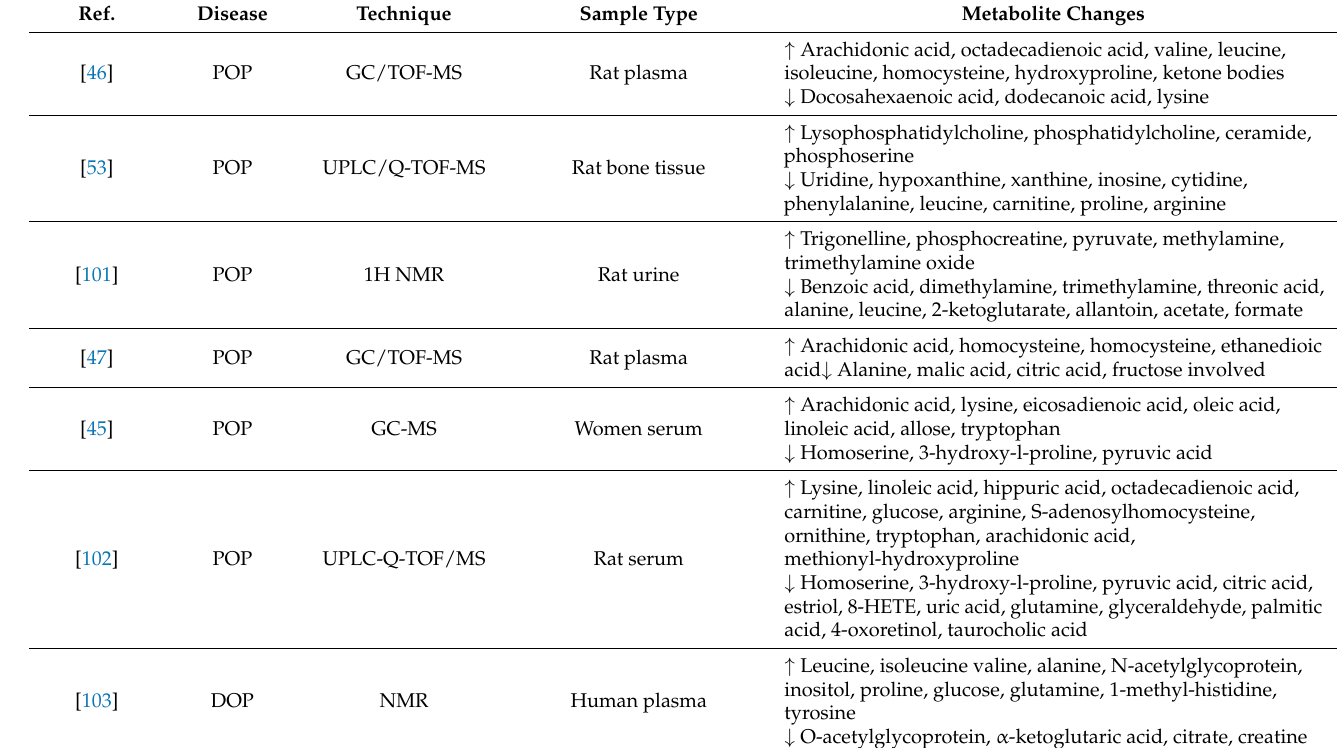
Table 1. Overview of reported metabolite changes in the different diseases, used analytical methods and corresponding references.